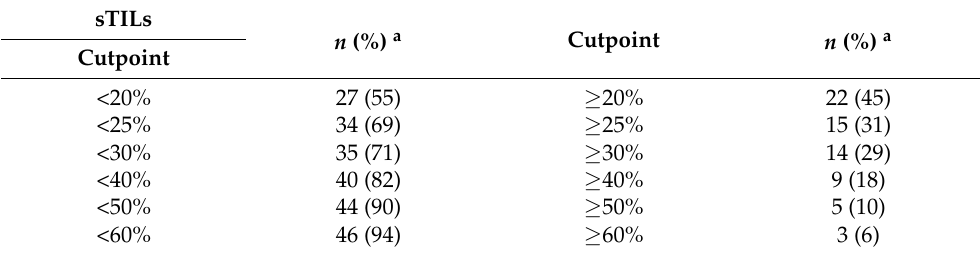
Table 2. Distribution of TNBC Cases According to Binary Categories Defined by sTILs